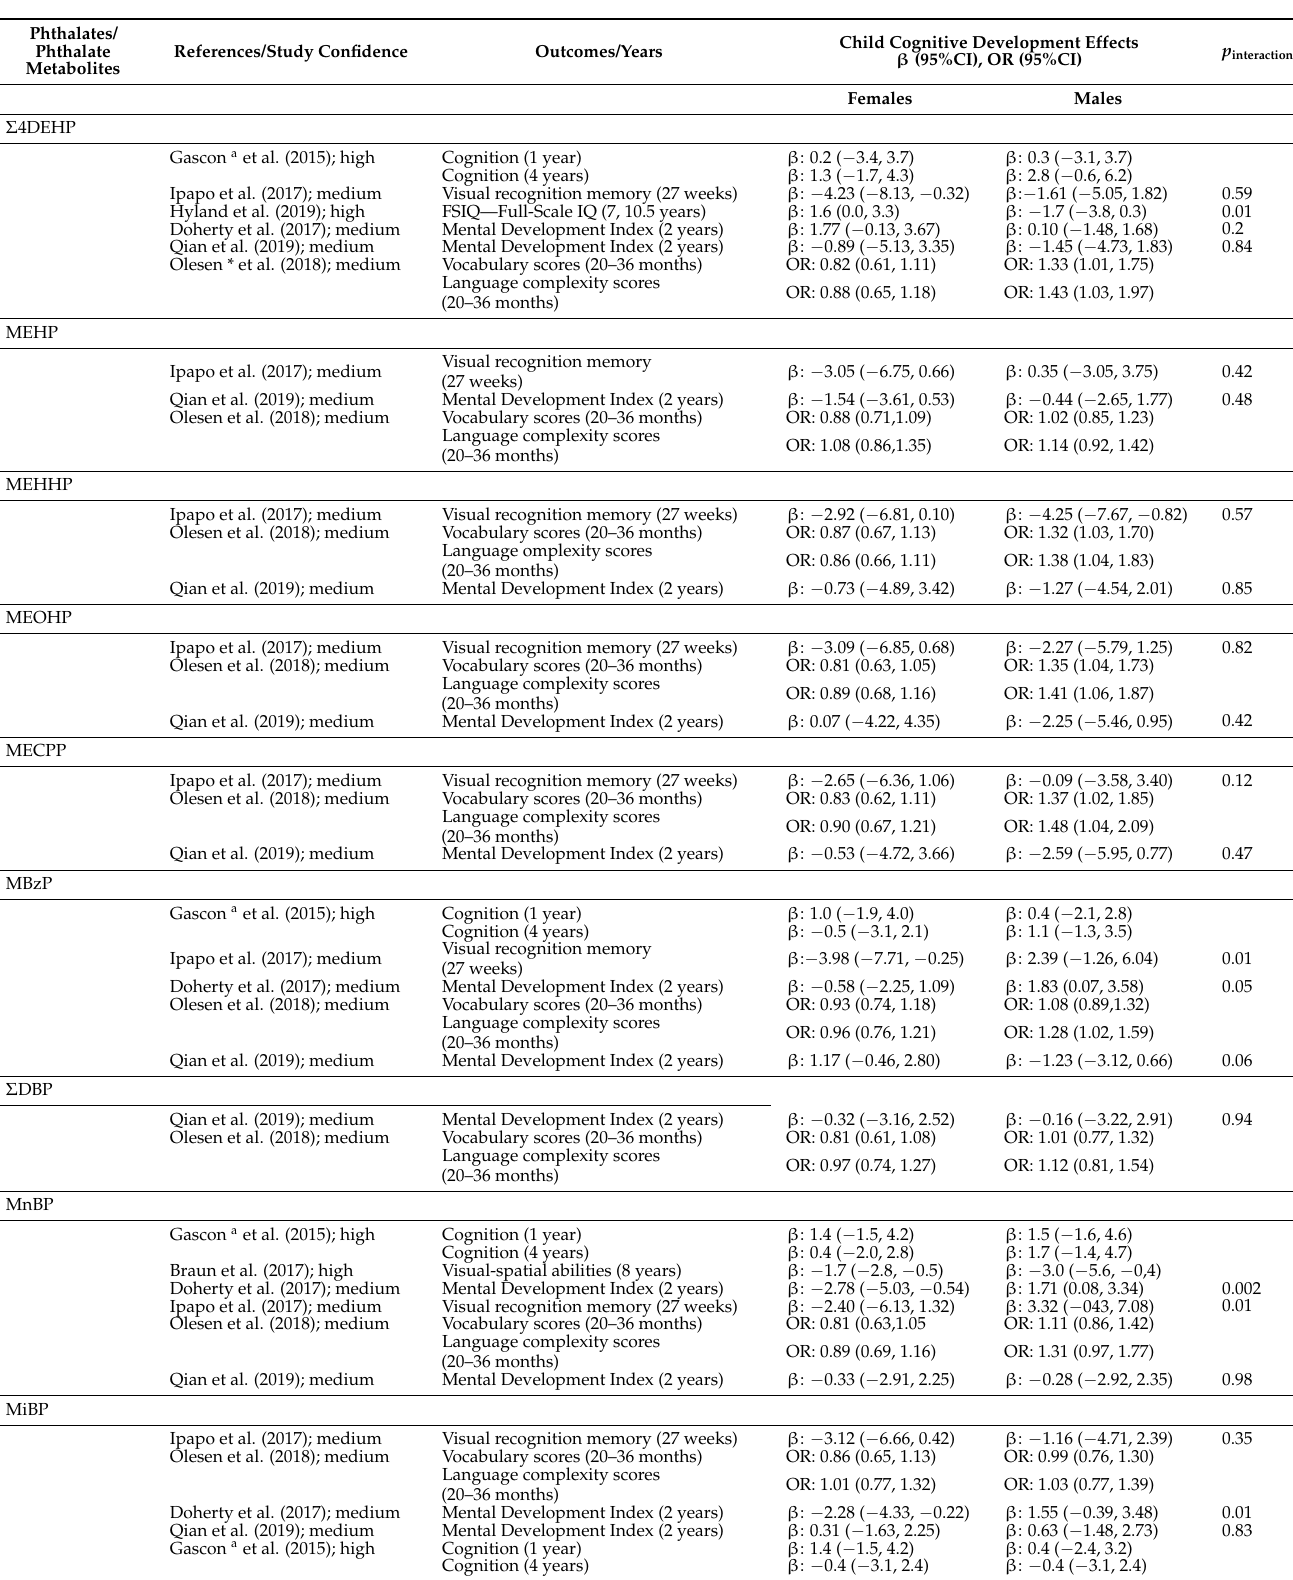
Table 3. Sex-specific difference between phthalates exposure and child